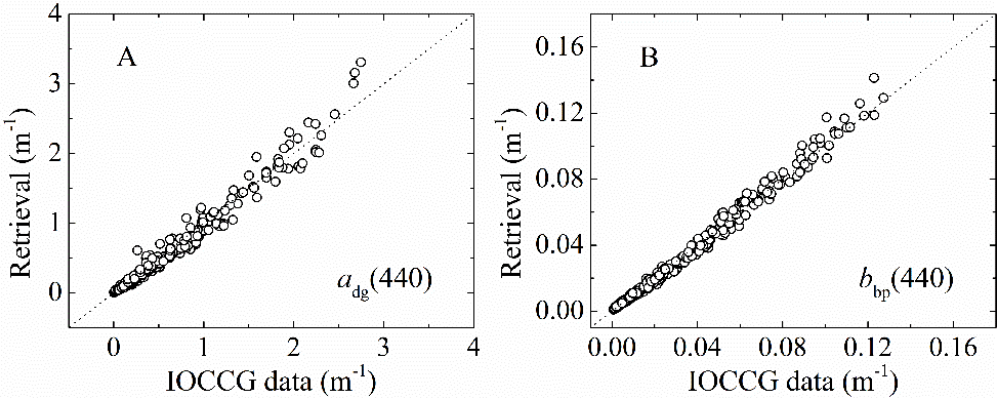
Figure 4. MuPI retrieved a dg (440) and b bp (440) versus those from the International Ocean-Colour Coordinating Group (IOCCG)